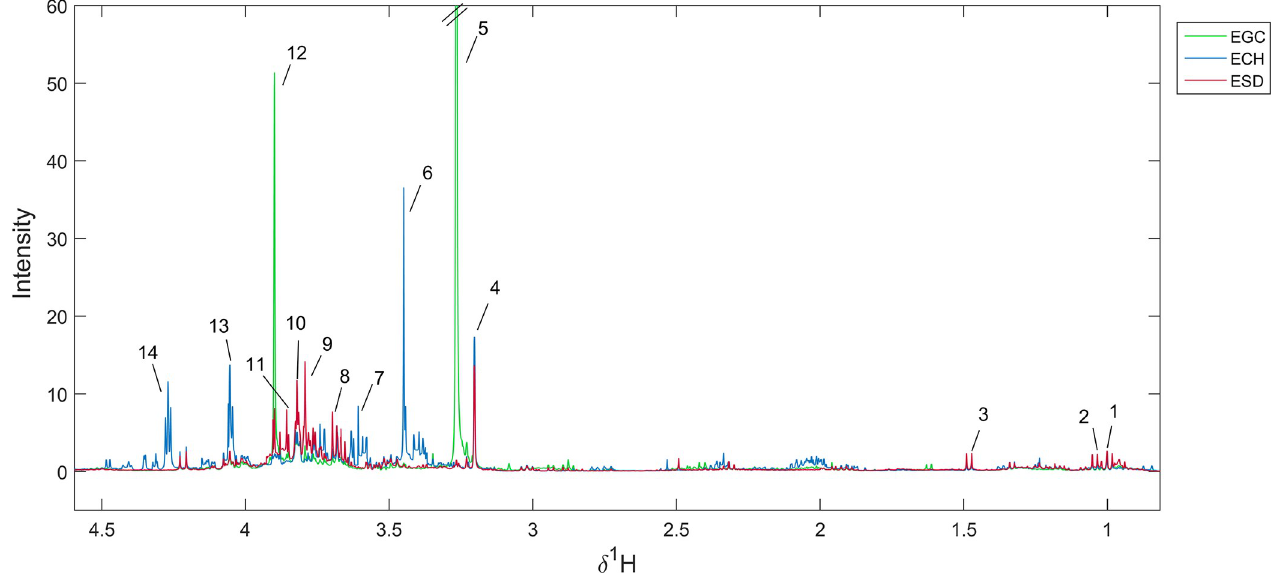
Fig 7. Median spectra of different crude extracts. (Key: 1 = valine; 2 = octane; 3 = alanine; 4 = xylulose; 5,12 = betaine; 6,13 = inositol; 7 = s-(5’-Adenosyl)-L- methionine; 8,9 = lignin compound 2012; 10 = glycyl-glycine; 11 = allose; 12 = coniferin, 14 = inositol phosphate).